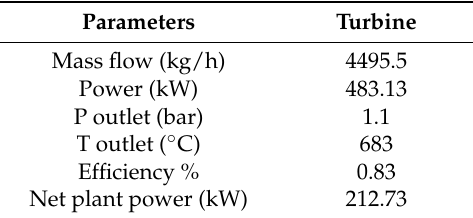
Table 10. Turbine performance as from the modeling